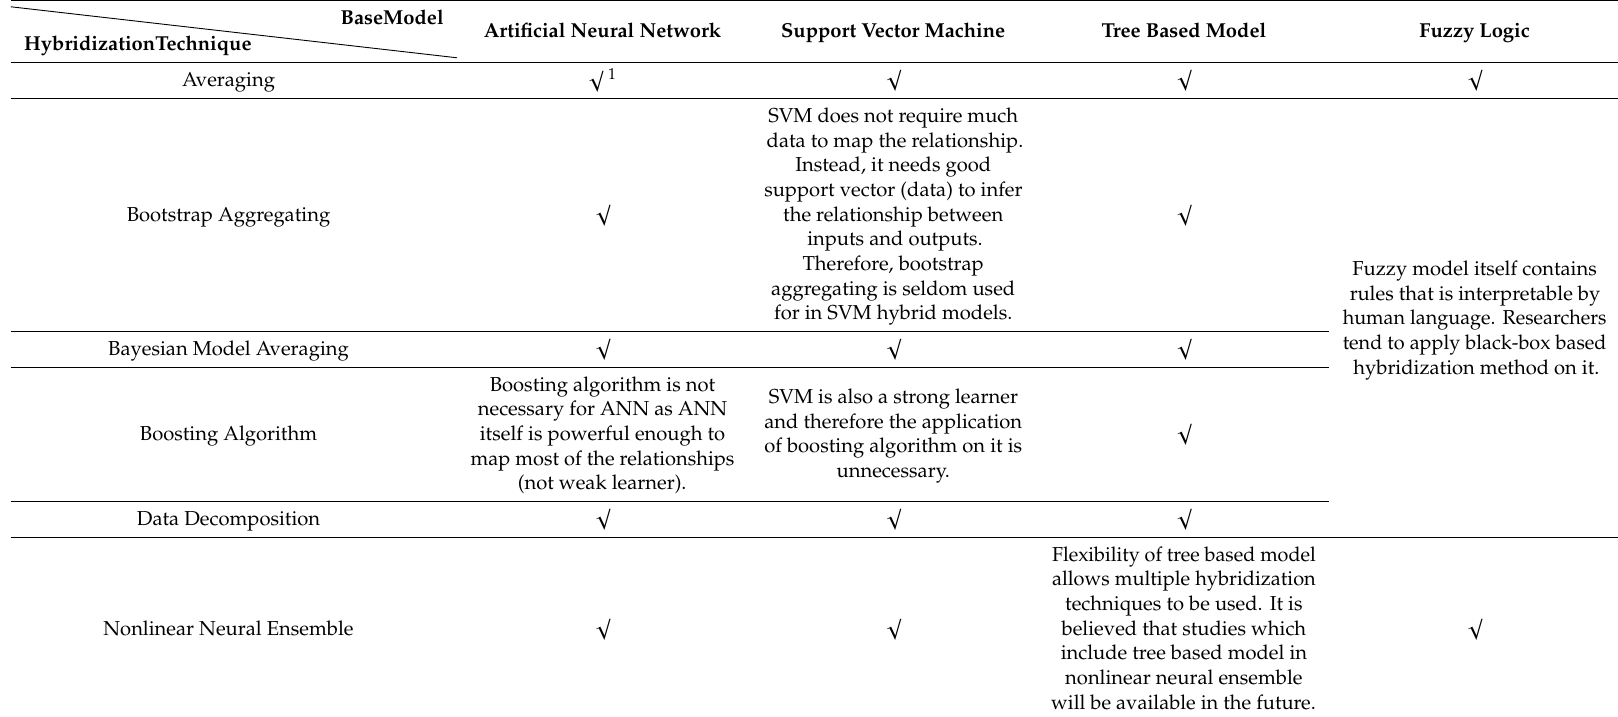
Table 5. Mapping of hybridization techniques for artificial intelligence